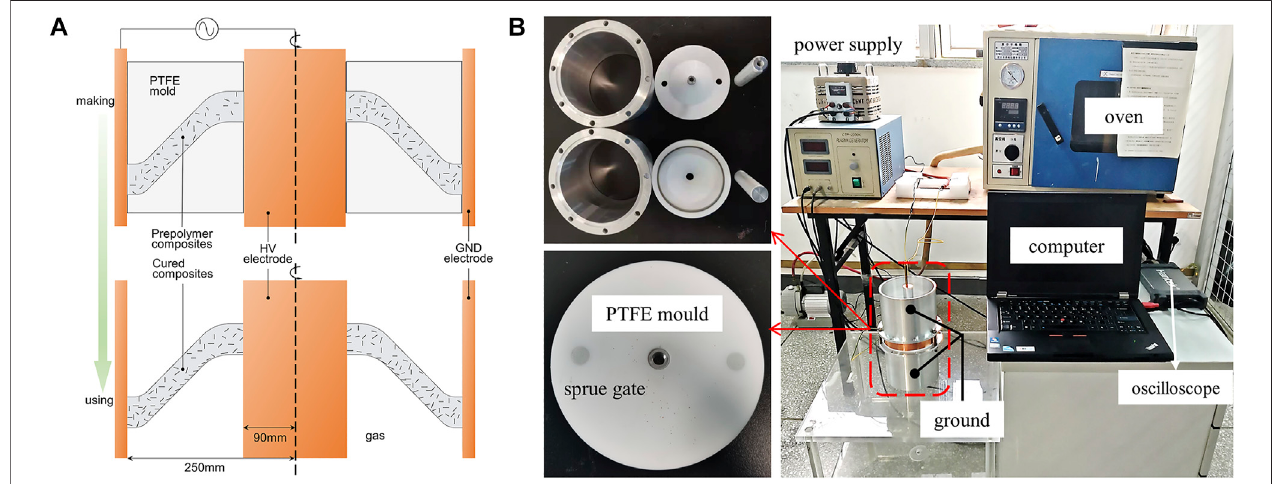
FIGURE 5 | Experimental setup for fabrication of basin insulators by EIA method: (A) cross-sectional schematic; (B) optical image of the setup.